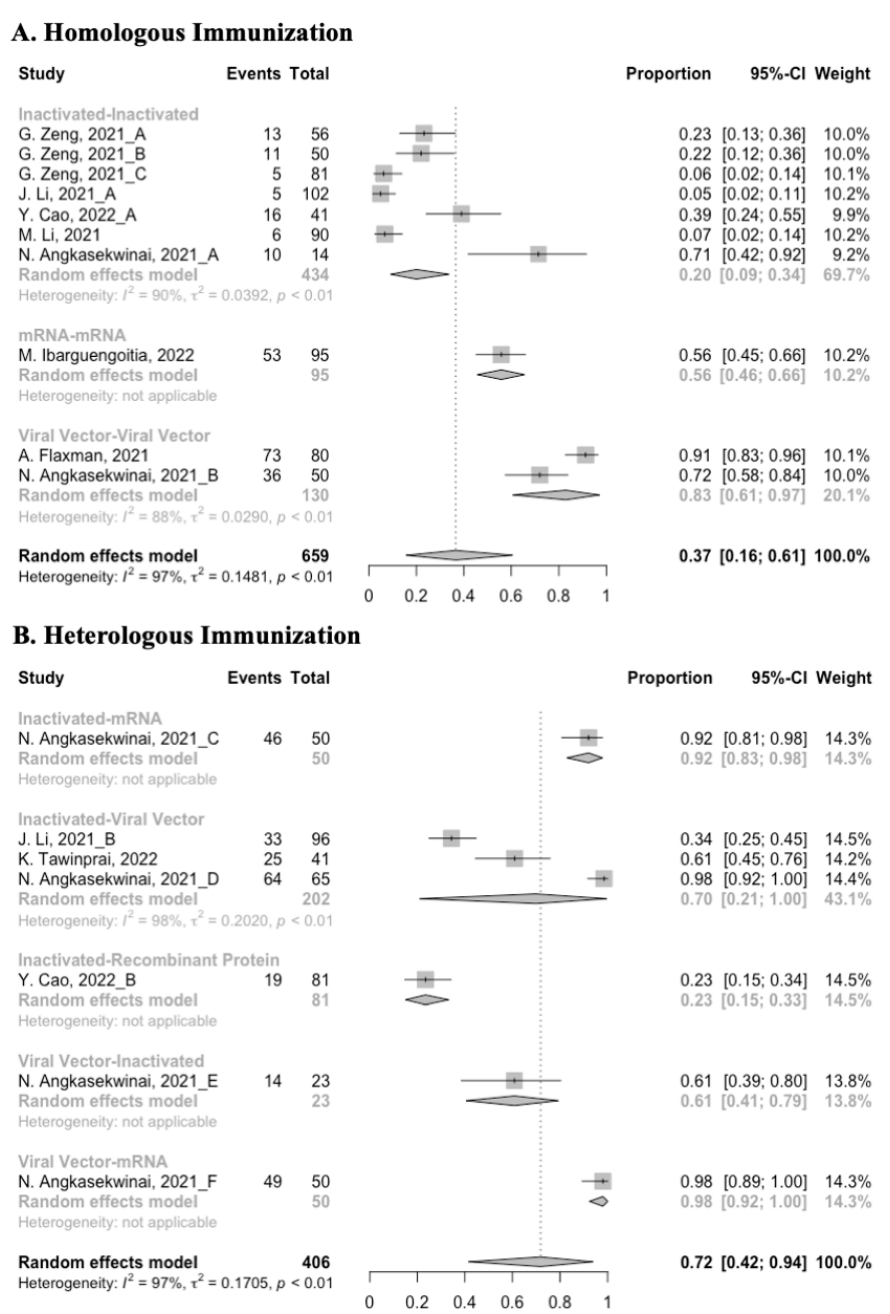
Figure 11. Forest plot of the overall incidence of total adverse events after booster vaccination.